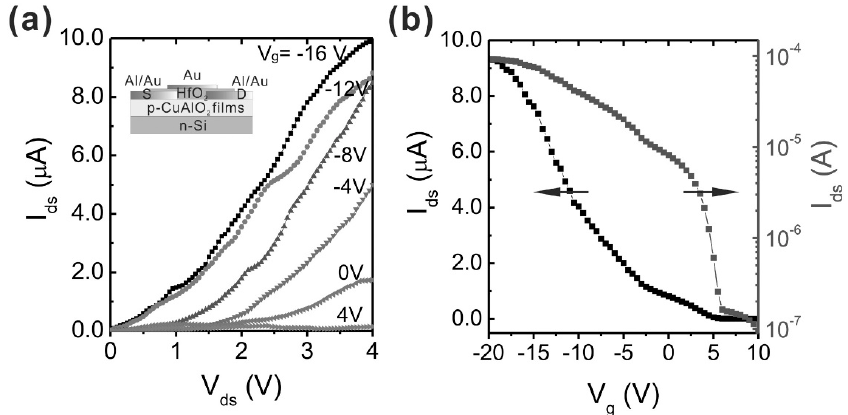
Figure 4. ( a ) The change of I ds against V ds at different V g values; ( b ) The change of I ds against V g at V ds at 3 V. Inset in ( a ) is the schematic drawing of the thin-film transistor (TFT). Reproduced with permission from Ref. [120]. Copyright 2012 AIP Publishing.